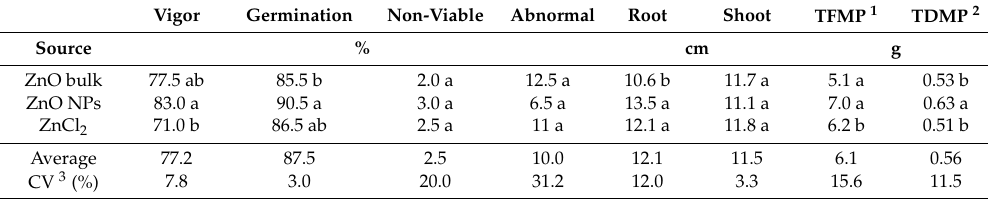
Table 2. Zinc sources e ff ects, independently of concentrations on vigor, germination, non-viable and abnormal seeds, root and shoot length and total fresh and dry biomass production of corn.